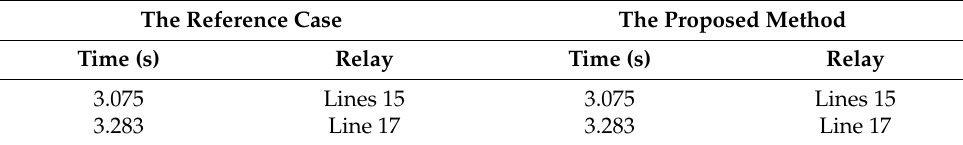
Table 7. The list of all distance relay operations in Contingency 3 .